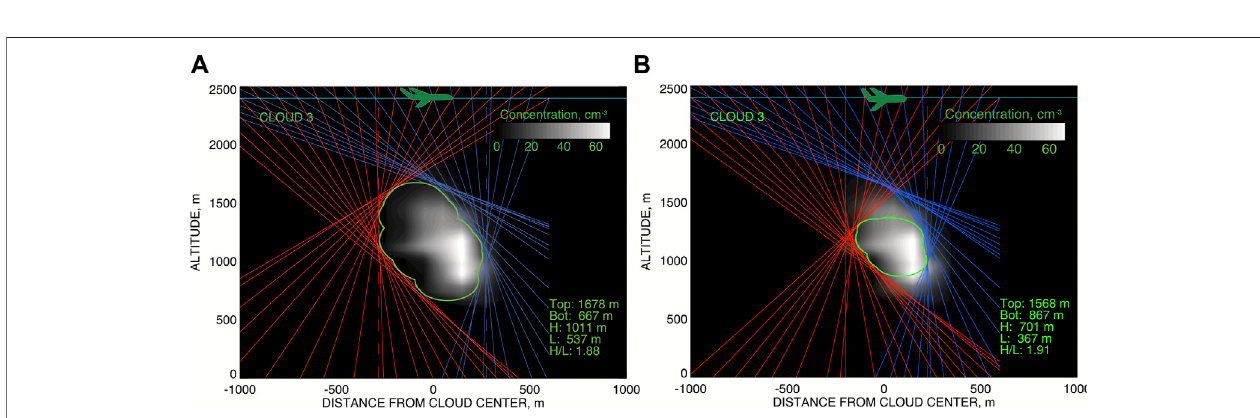
FIGURE 5 | (A) derivation of the cloud shape (corresponding to the re fl ectance threshold of 0.0015) by cutting out a polygon in 2D space using the RSP view rays tangent to cloud surface and fi lling this polygon with a realistic cloud-shape curve. The initial droplet number concentration density is shown by grey-scale contour plot. This plot is reproduced from Alexandrov et al. (2016a). (B) Same as (A) but for the bright-cloud side threshold of 0.030 and the shadow-side threshold of 0.005.